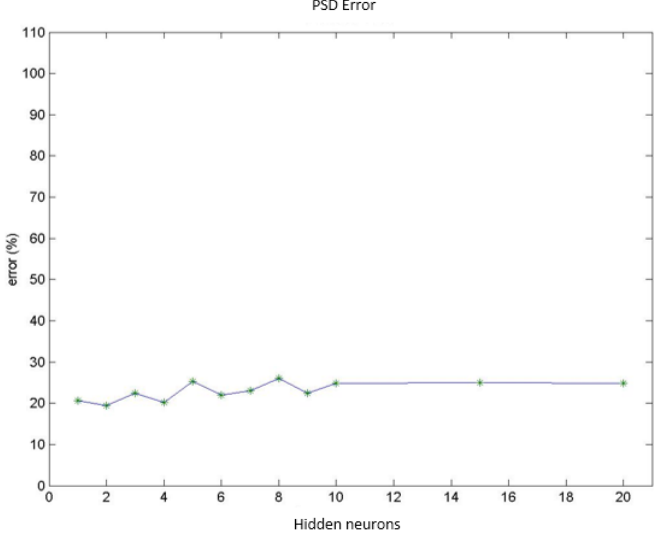
Figure 9. Diagnosis error (mean value) obtained using only PSD parameters .